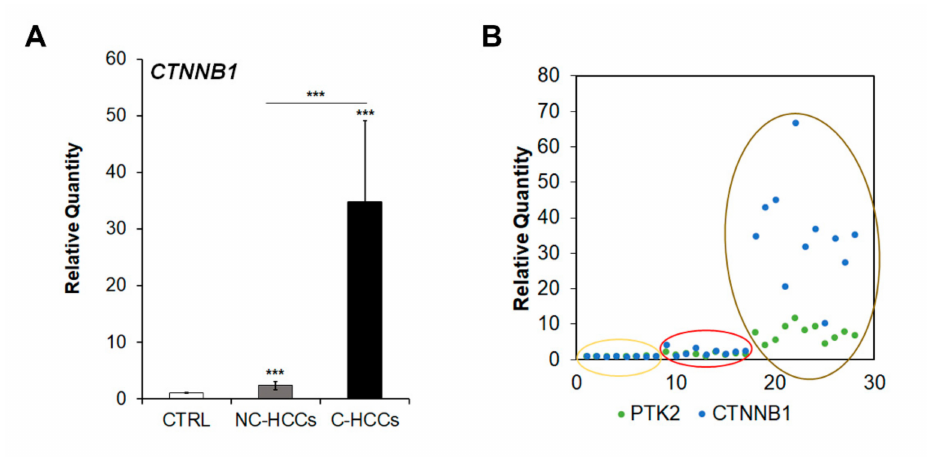
Figure 6. CTNNB1 overexpression in pediatric HCCs. ( A ) Relative mRNA expression of CTNNB1 gene measured by qRT-PCR in NC-HCCs and C-HCCs vs. ***, p < 0.01 CTRL samples. ( B ) Relative co-expression of PTK2 and CTNNB1 in CTRL (yellow circle) NC-HCCs (red circle), and C-HCCs (brown